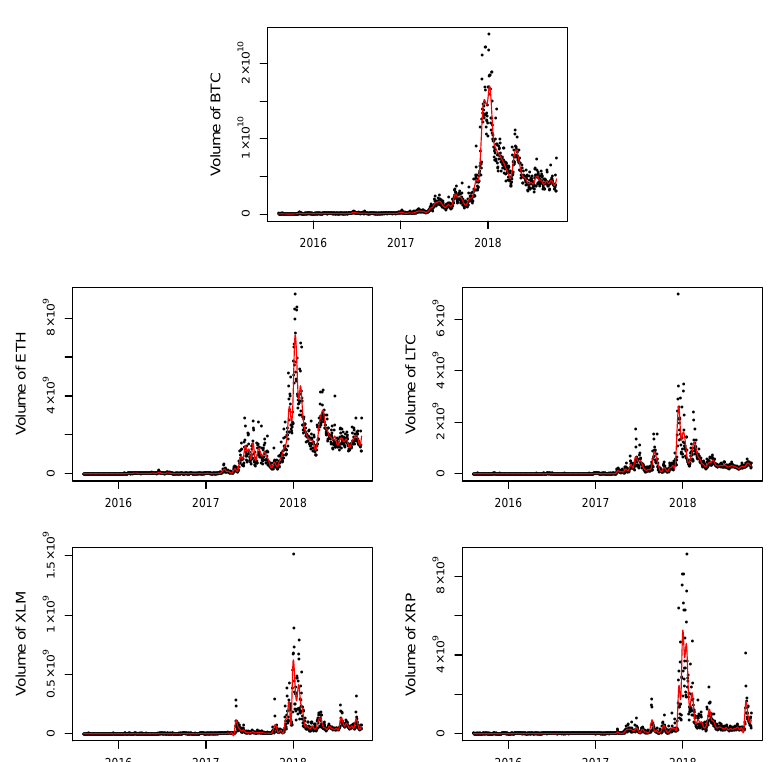
Figure 4. Smoothing spline fit to the volumes of the five cryptocurrencies.